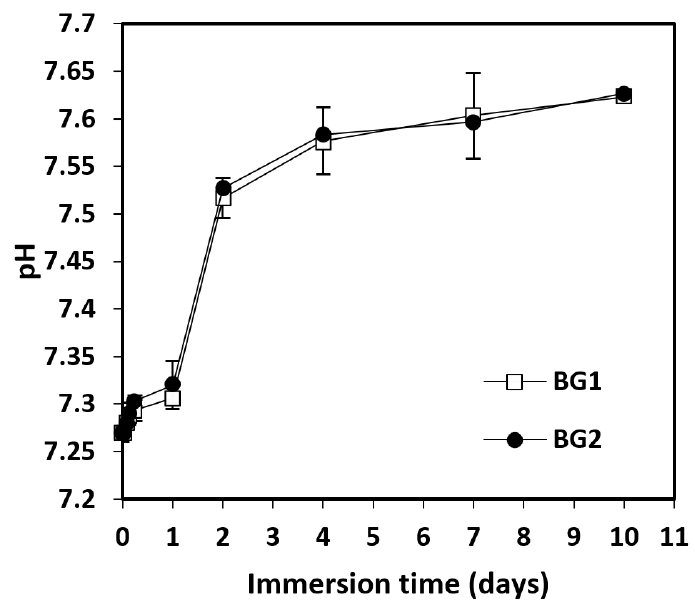
Figure 2. pH values of BGs immersed in PBS at 37 °C as a function of immersion time (BG1, 100[2B 2 O 3 · CaF 2 ]; BG2, 0.5V 2 O 5 · 99.5[2B 2 O 3 · CaF 2 ]). Mean ± SD, n = 3.